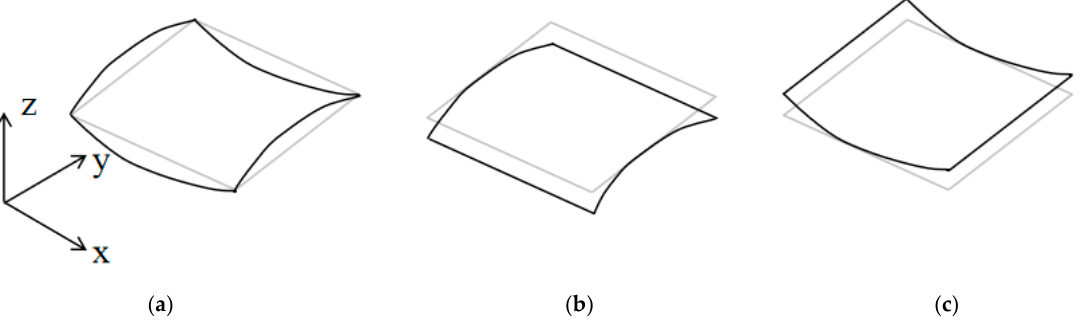
Figure 1. The configurations of a bi-stable cross-ply laminate. ( a ) Saddle-shaped configuration; ( b ) Cylindrical stable state A; ( c ) Cylindrical stable state B.